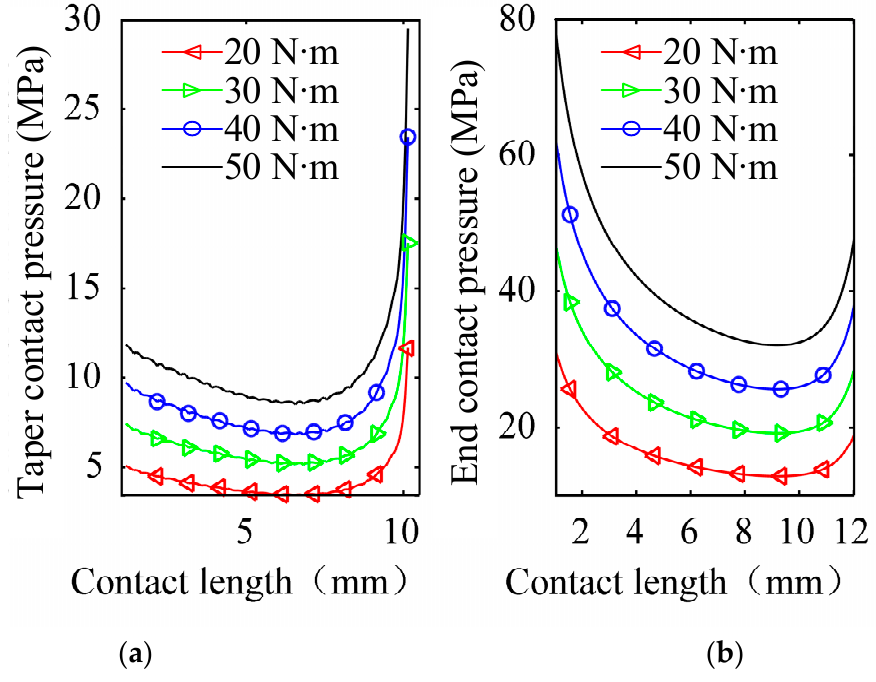
Figure 10. Effect of tightening torque on contact pressure of the spindle–GWF interface: ( a ) effect of tightening torque on tapered contact pressure of interface; ( b ) effect of tightening torque on end contact pressure of interface.